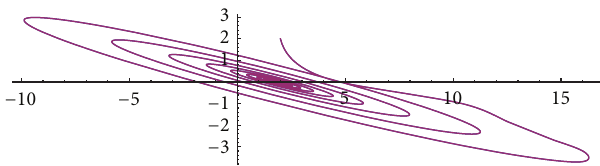
Figure 1: Equilibrium 𝐸 ∗ is locally asymptotically stable when 𝜏 1 = = 0.8 < 𝜏 0 0.7 , 𝜏 2 2 .